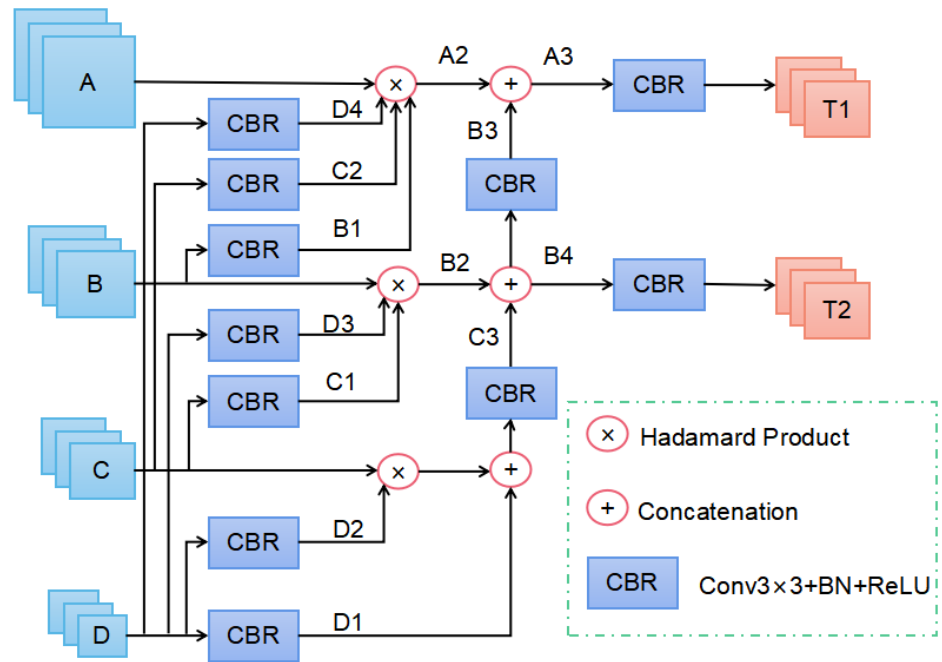
Figure 3. Structure diagram of multi-proportion fusion module.